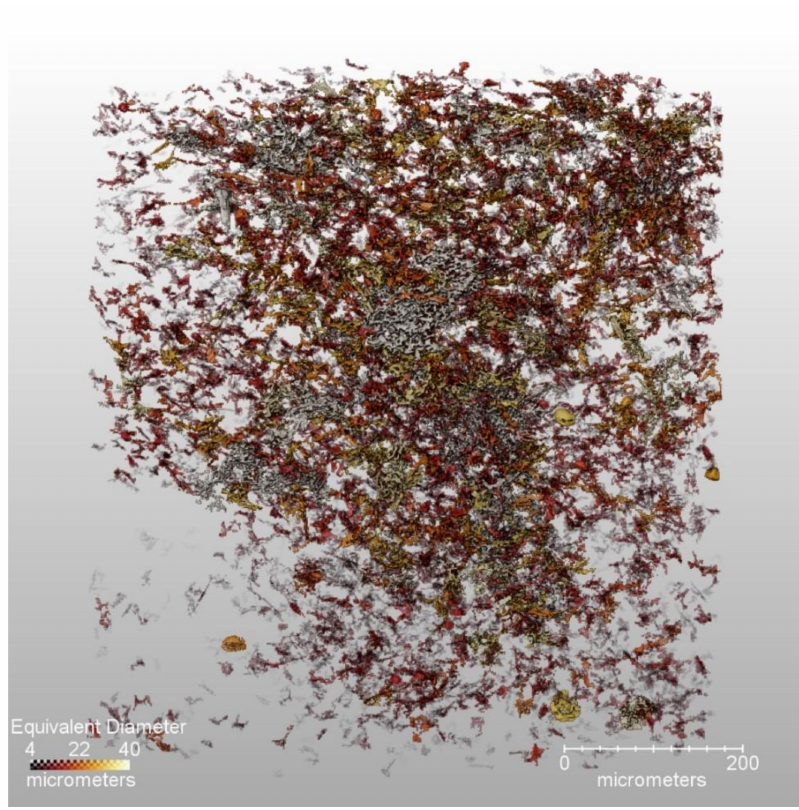
Figure 9. 3D rendering of the voids within the Composition B explosive, colored by equivalent diameter. The largest voids are about 40 µ m in equivalent diameter, but in reality, they are mostly flat planes throughout the sample. The voids are not evenly distributed and occupy 2% of the total